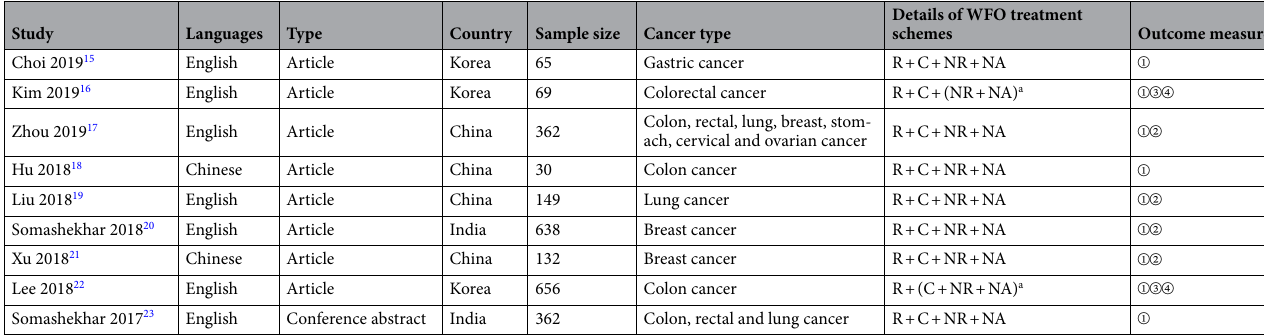
Table 1. Main characteristics of publications included in this meta-analysis. R Recommended, C for consideration, NR not recommended, NA not available. ① Clinical staging, ② Pathological subtypes, ③ ECOG performance status, ④ Age. a The data in brackets represent that only the merged data were given, and not each item of data was given